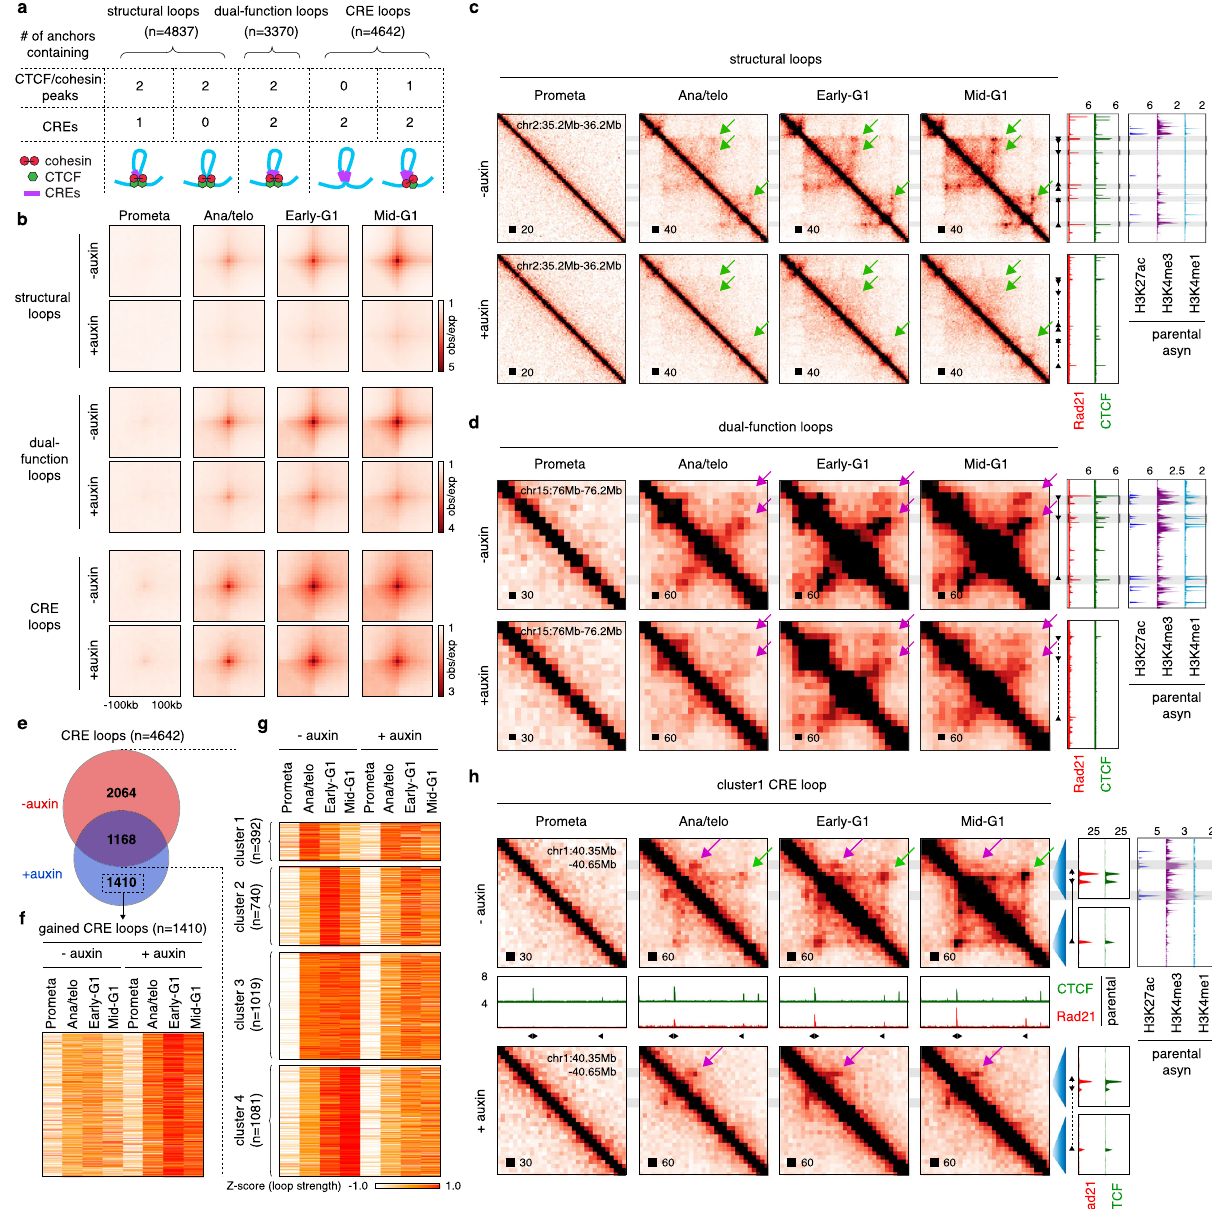
CRE loops ” ) based on the presence at their anchors of CTCF/cohesin co-occupied sites and CREs. CRE denotes cis-regulatory element. b APA plots showing the signals of loop categories before and after CTCF depletion across cell cycle stages. Bin size: 10 kb. c KR balanced Hi-C contact matrices of representative regions containing structural loops. Bin size: 10 kb. Tracks of CTCF and Rad21 with or without auxin treatment as well as